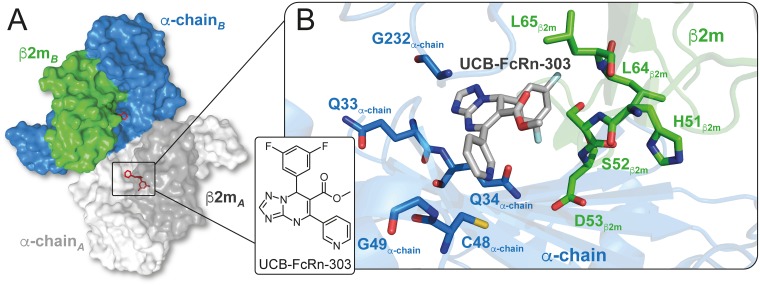
Crystal structure of the compound UCB-FcRn-303 (R enantiomer) bound to FcRnECD.(A) The protein crystallized as a dimer composed of two β2m (dark grey and green) and two α-chain (light grey and blue) molecules. (B) At the interface of β2m and the α-chain, UCB-FcRn-303 (grey) occupies a binding pocket with Glycine, Cysteine, hydrophobic (Leucine), charged (Histidine, Aspartate), and polar uncharged (Serine, Glutamine) residues. β2m, β2-microglobulin; FcRn, neonatal Fc receptor; FcRnECD, extracellular domain of the neonatal Fc receptor.